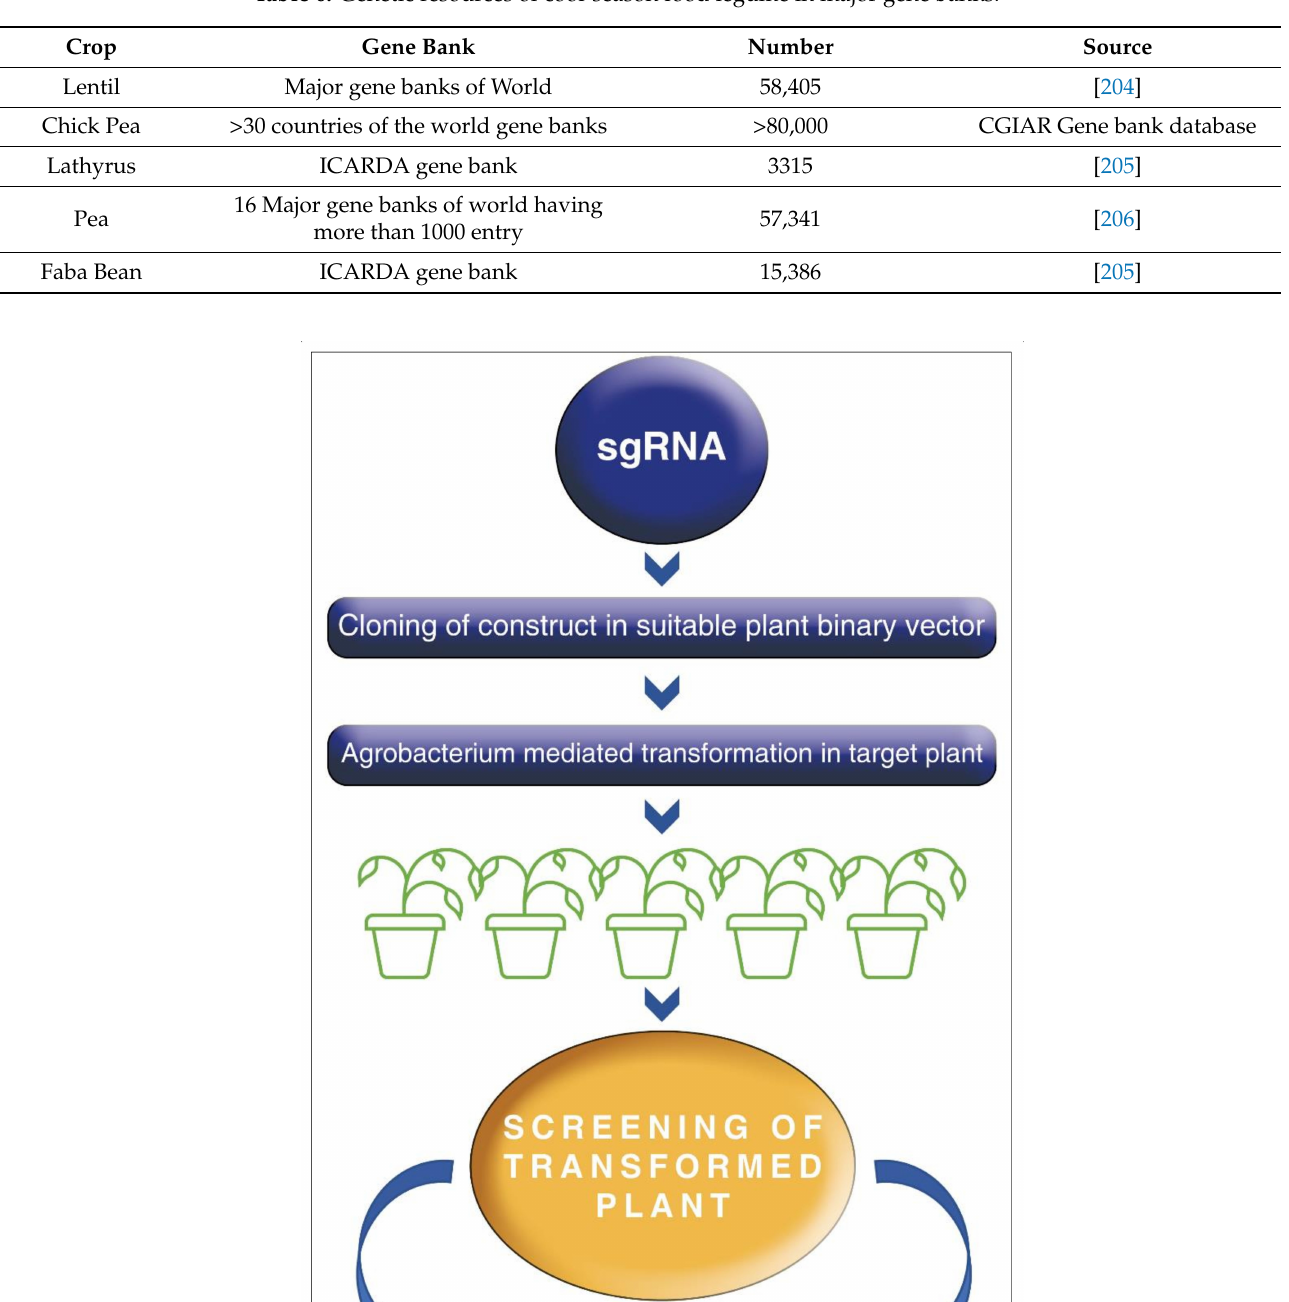
Table 6. Genetic resources of cool-season food legume in major gene banks.